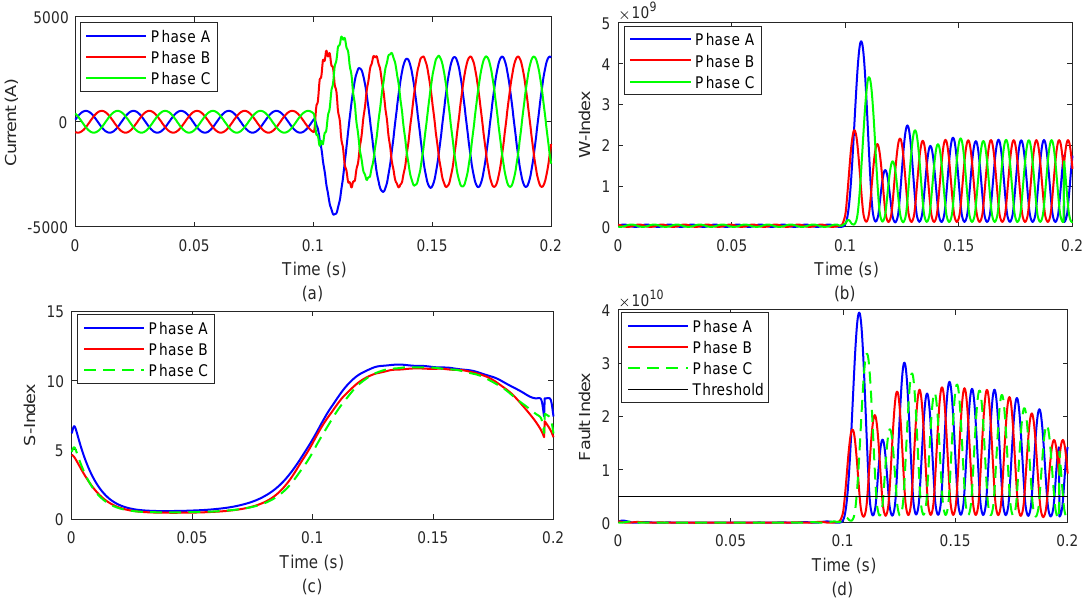
Figure 6. Identification of the fault with an LLL-G nature: ( a ) signals of the current, ( b ) W-index, ( c ) S-index, and ( d ) FI.